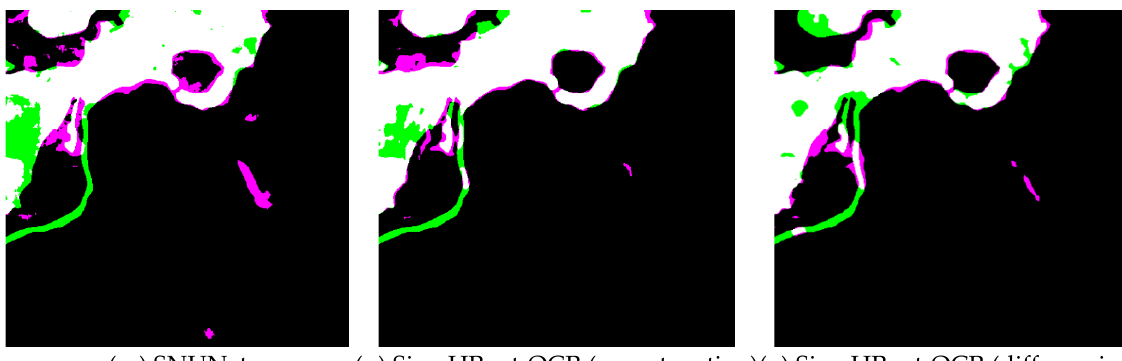
Figure 12. Visual comparison of the change detection results on irregularly shaped objects (the green and magenta color represents missing pixels and false-detected pixels in the change detection result, respectively).